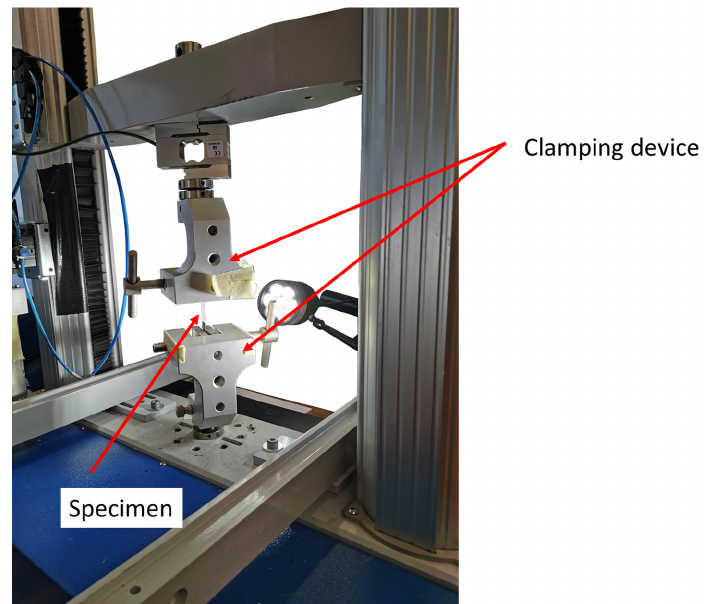
Figure 2. Experimental setup for the tension tests on the PE isolator specimen. Energies 2021 , 14 , x FOR PEER REVIEW